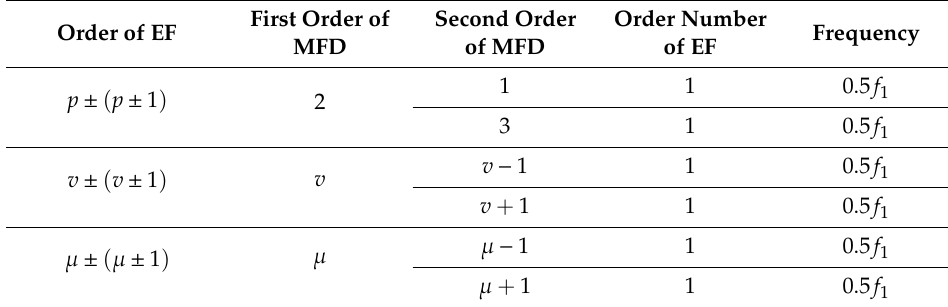
Table 2. The 1 × rotation frequency components of electromagnetic forces under dynamic air gap eccentricity. MFD—magnetic flux